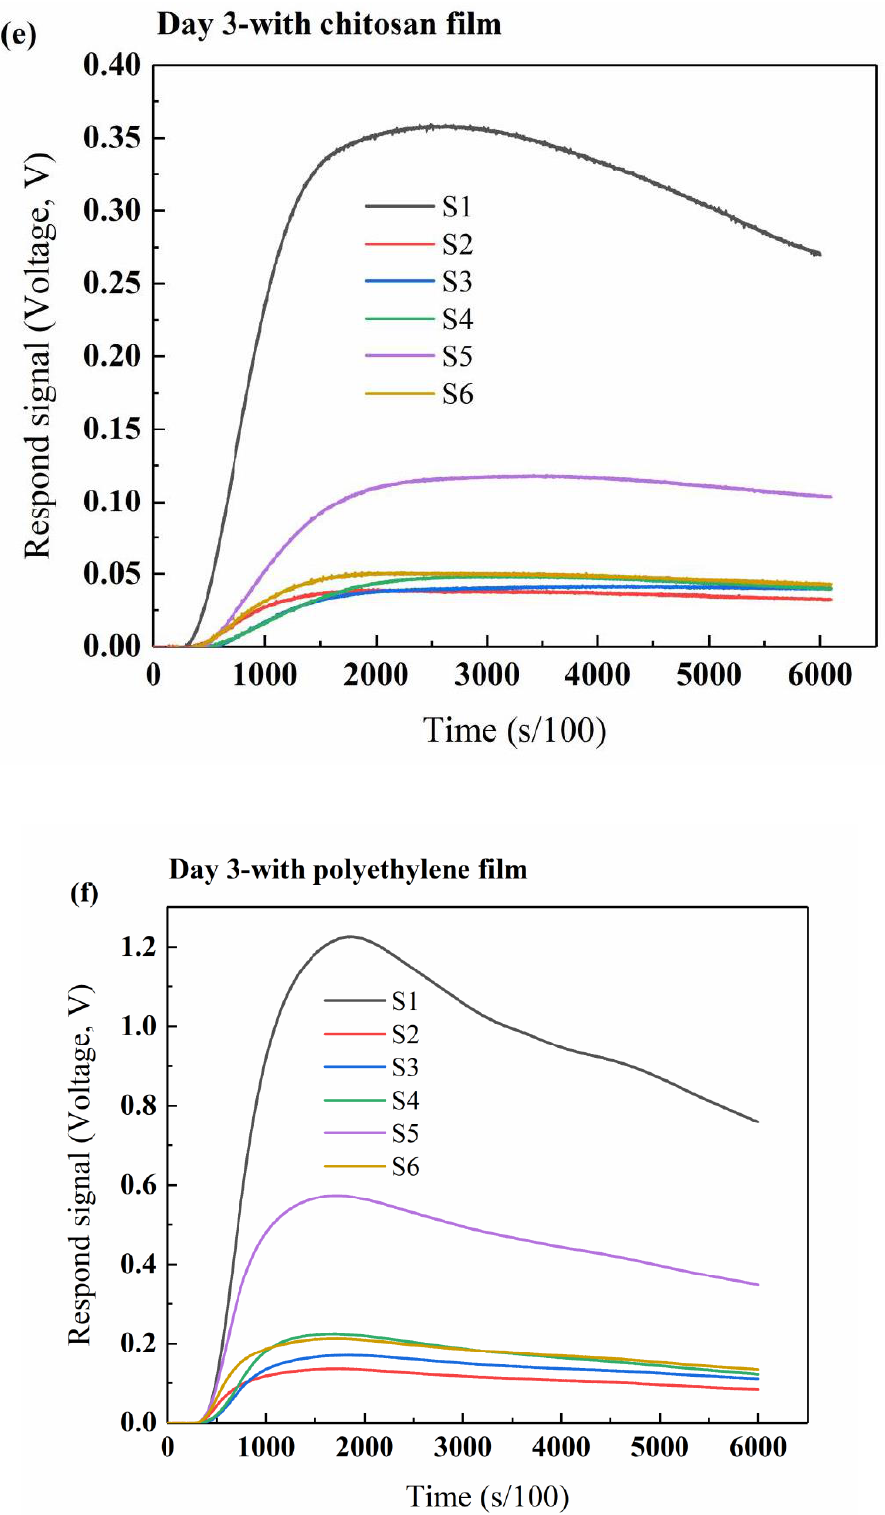
Figure 8. The typical original electronic nose response signals of ground beef sealed with chitosan film and polyethylene film at 8 °C for different amounts of days. The typical original electronic nose response signals of ground beef sealed with chitosan film for ( a ) 1 day, ( c ) 2 day and ( e ) 3 day, and polyethylene film for ( b ) 1 day, ( d ) 2 day and ( f ) 3 day at 8 °C